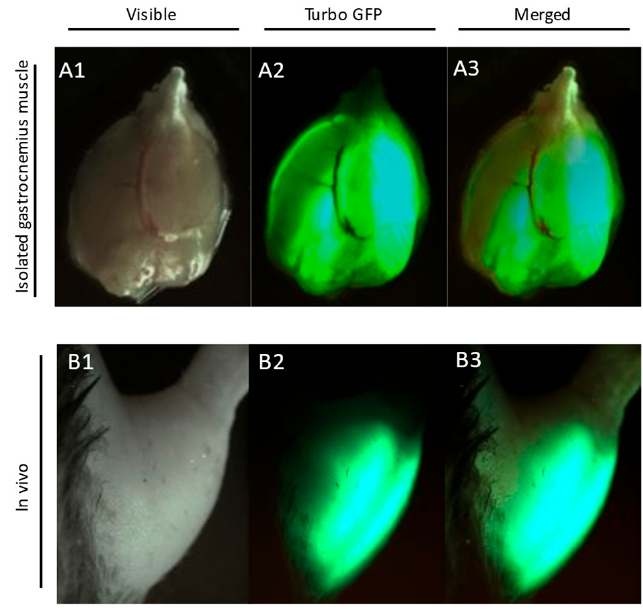
Figure 1. TurboGFP reporter gene expression in gastrocnemius muscle. Images were taken at 6 weeks after plasmid transfection: Panel A1 —visible light photo of isolated mouse gastrocnemius muscle; Panel A2 —Turbo-GFP fluorescence of electroporated gastrocnemius; Panel A3 — A1 and A2 merged; Panel B1 —visible light photo of mouse hindlimb; Panel B2 —transcutaneous Turbo-GFP fluorescence of electroporated gastrocnemius; Panel B3 — B1 and B2